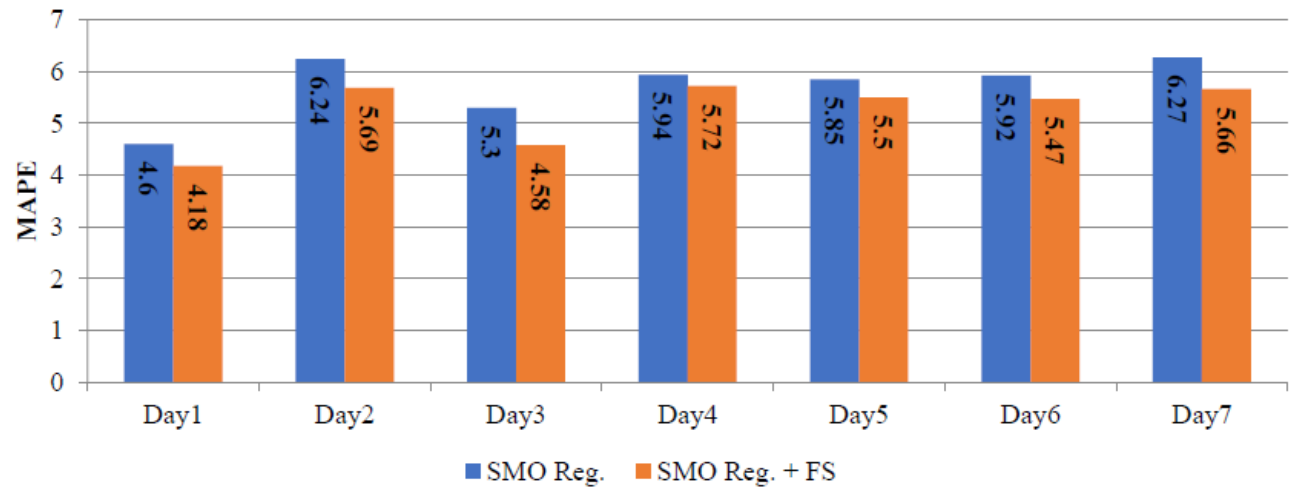
Energies 2021 , 14 , x FOR PEER REVIEW Figure 7. Daily MAPE corresponding to SMO reg. and SMO reg.+ FS for spring season.